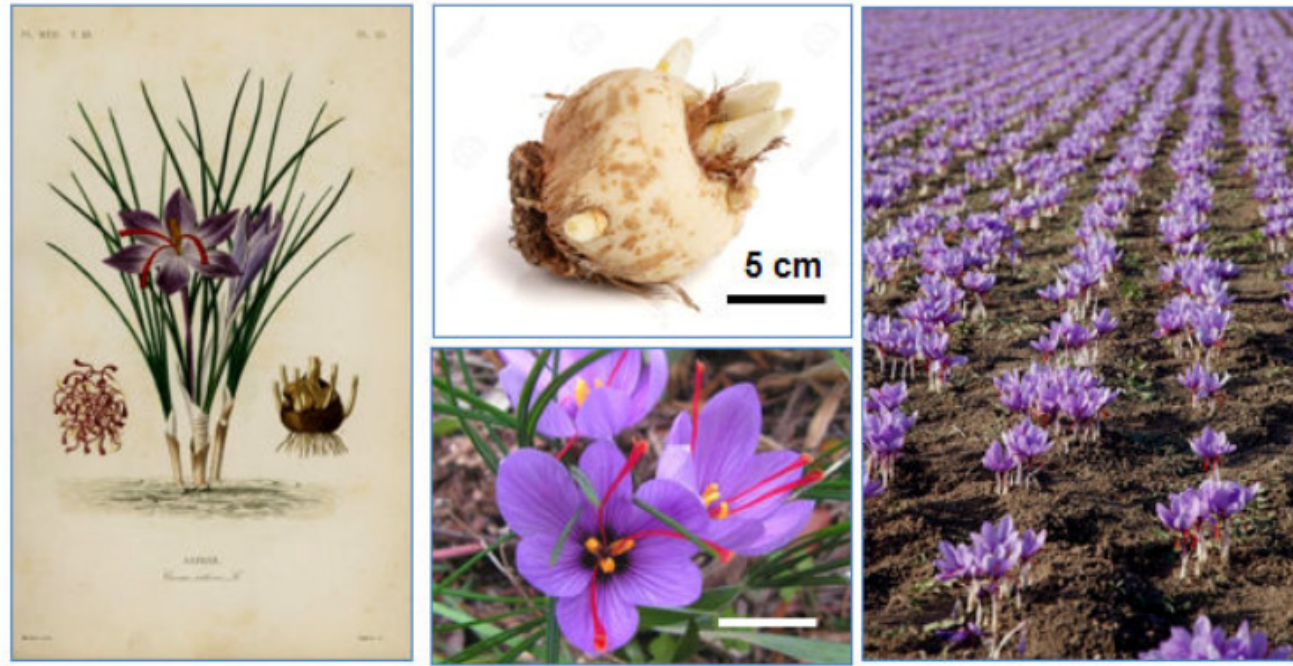
Figure 2. Aspects of saffron. Bulbous call cormus and flowers with stigmas are shown. The engraving corresponds to a picture of a botanical board (Illustration from Pierre-Oscar Reveil. Le règne végétal, Flore médicale, L. Guérin, Paris, 1864–1871).